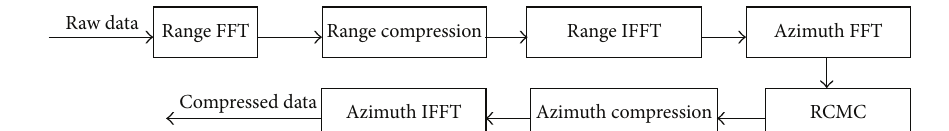
Figure 5: Flowchart of RDA.